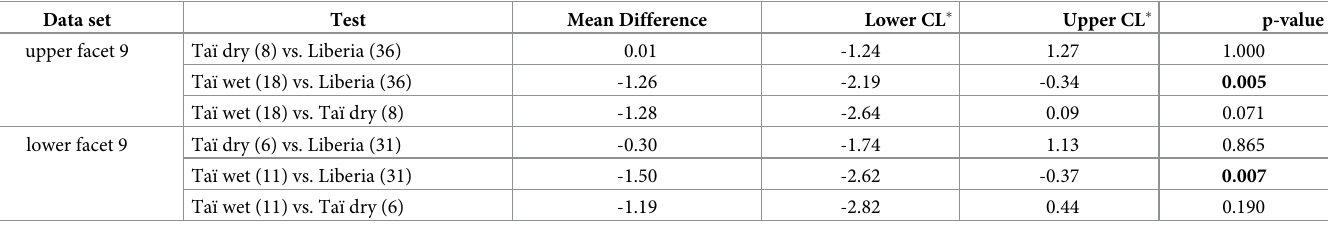
Table 2. Post-hoc Tukey’s Test for the scores of factor 1 and 2 of the factor analysis comparing Liberian chimpanzees to Ta ï chimpanzees from dry and rainy period. Data set Test Mean Difference Lower CL � Upper CL � p-value upper facet